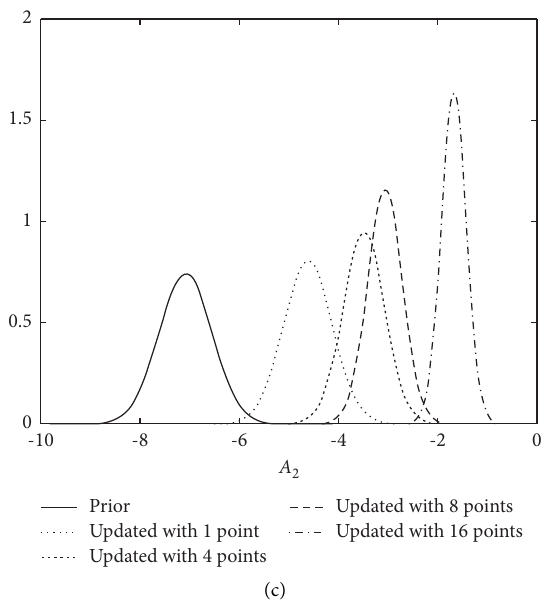
1 , (b) parameter A 2 , and (c)